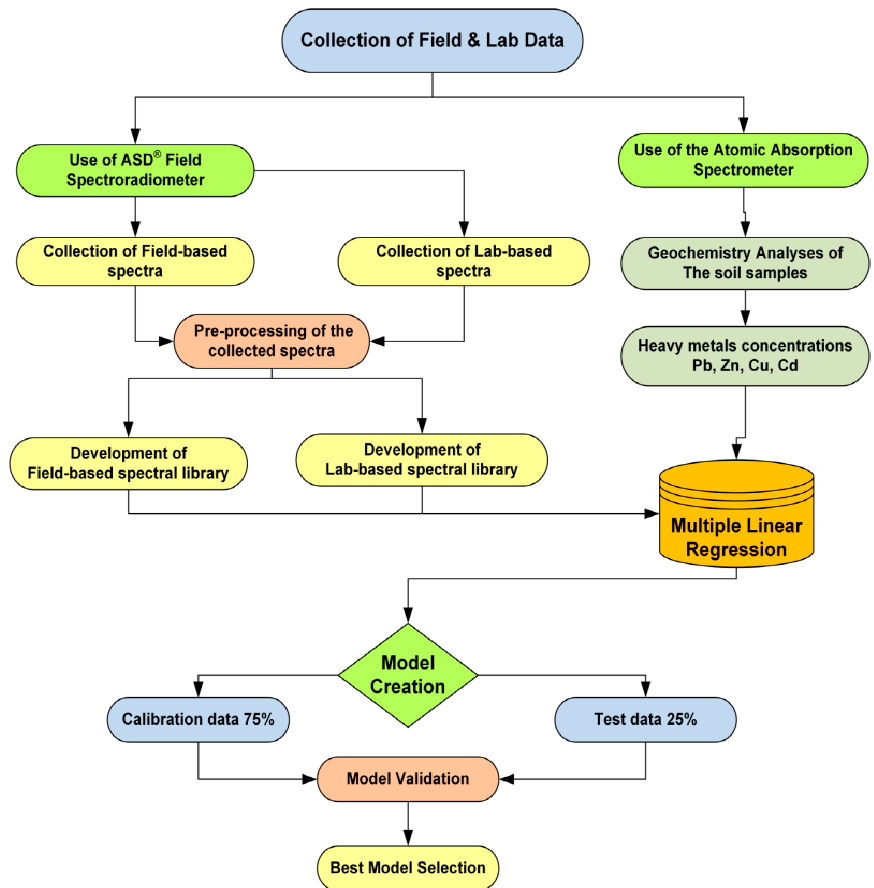
Figure 3. Flowchart showing the methodology steps implemented in this study.